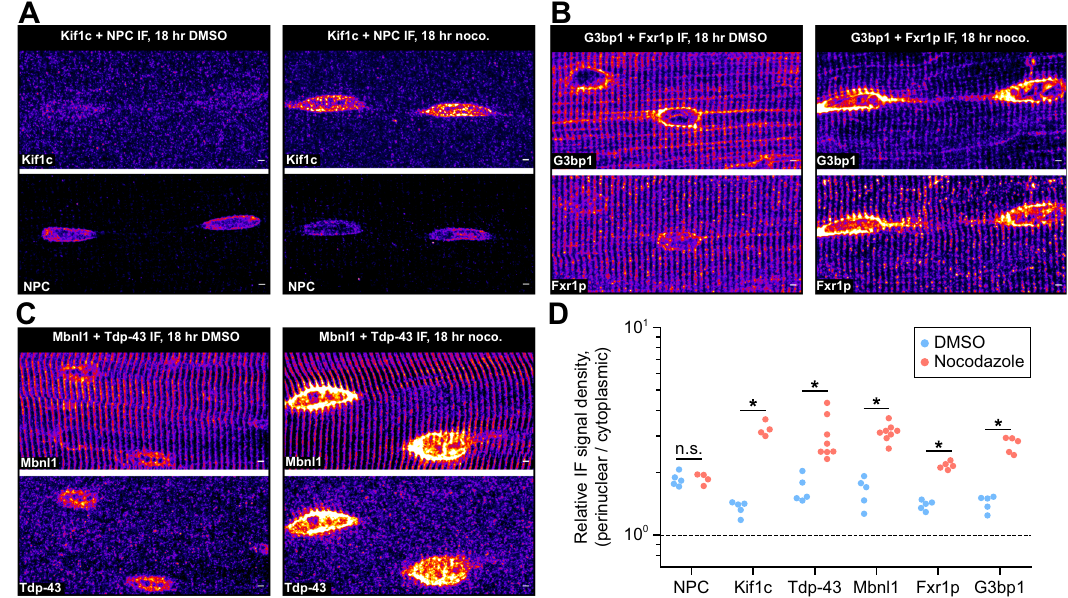
Fig. 7 Regulators of RNP granule formation, transport, and translation co-accumulate at the nuclear periphery of nocodazole-treated myo fi bers. A Representative images of Co-IF against the nuclear pore complex (NPC, labeled with mAb 414) and Kif1C in myo fi bers cultured for 18 h in the presence of nocodazole or control (DMSO). Scale bars: 2 µ m. B Representative images of Co-IF against G3bp1 and Fxr1p in myo fi bers cultured for 18 h in the presence of nocodazole or control (DMSO). See also Supplementary Fig. 6A, B. Scale bars: 2 µ m. C Representative images of Co-IF against the Mbnl1 and Tdp-43 in myo fi bers cultured for 18 h in the presence of nocodazole or control (DMSO). Scale bars: 2 µ m. D Perinuclear to cytoplasmic relative IF signal density in nocodazole (red) and control (DMSO, blue) myo fi bers. n = 5 myo fi bers per protein/condition. * p < 0.05, Two-sided Mann – Whitney U